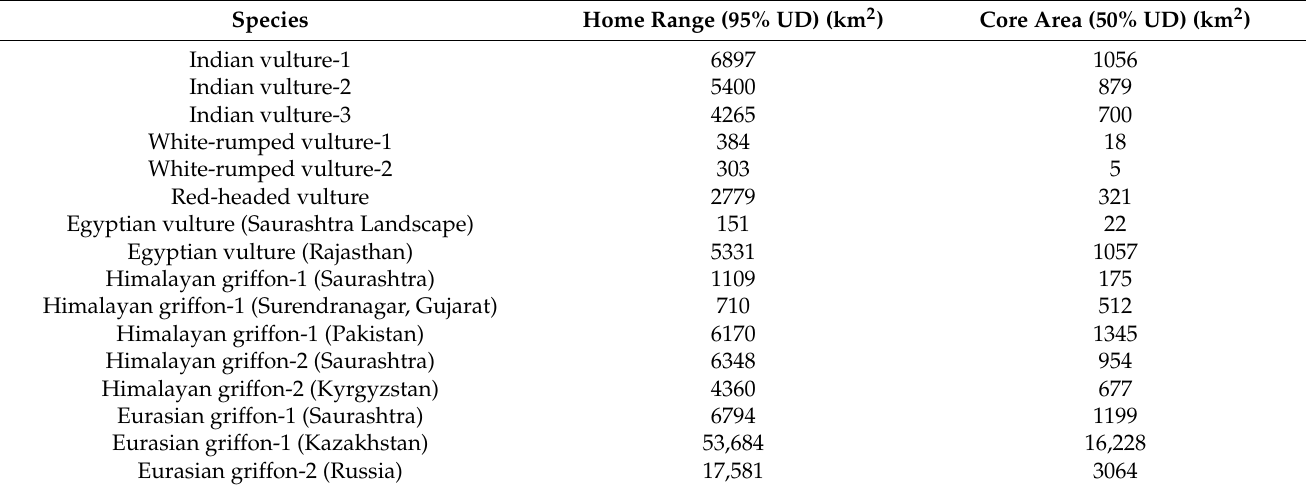
Table 1. Annual home range size (95% UD) and core area (50% UD) of eleven satellite-tagged individuals belonging to six vulture species as calculated using R package